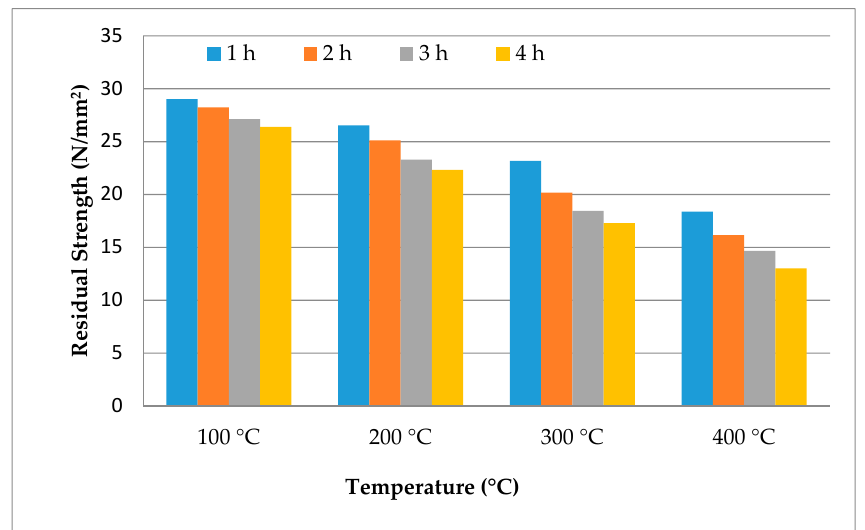
Figure 8. Temperature versus residual strength of CC mix.